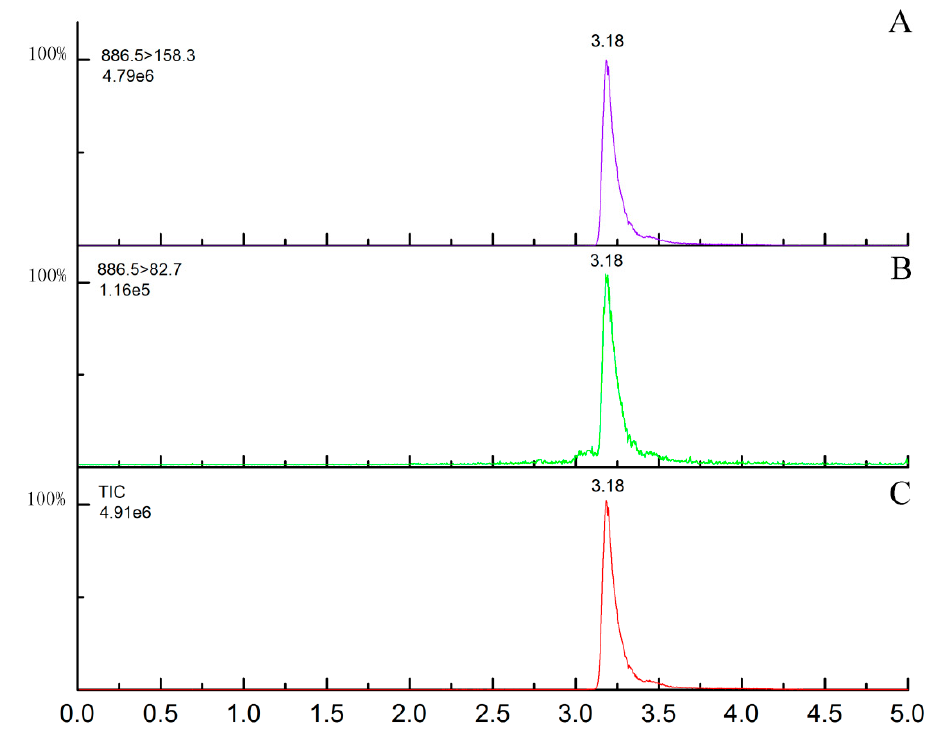
Figure 3. MRM (multiple reaction monitoring) mode chromatograms of emamectin standard (10 µ g L − 1 ). ( A ) The quantitative ion chromatogram; ( B ) the qualitative ion chromatogram; ( C ) the total ion chromatogram.